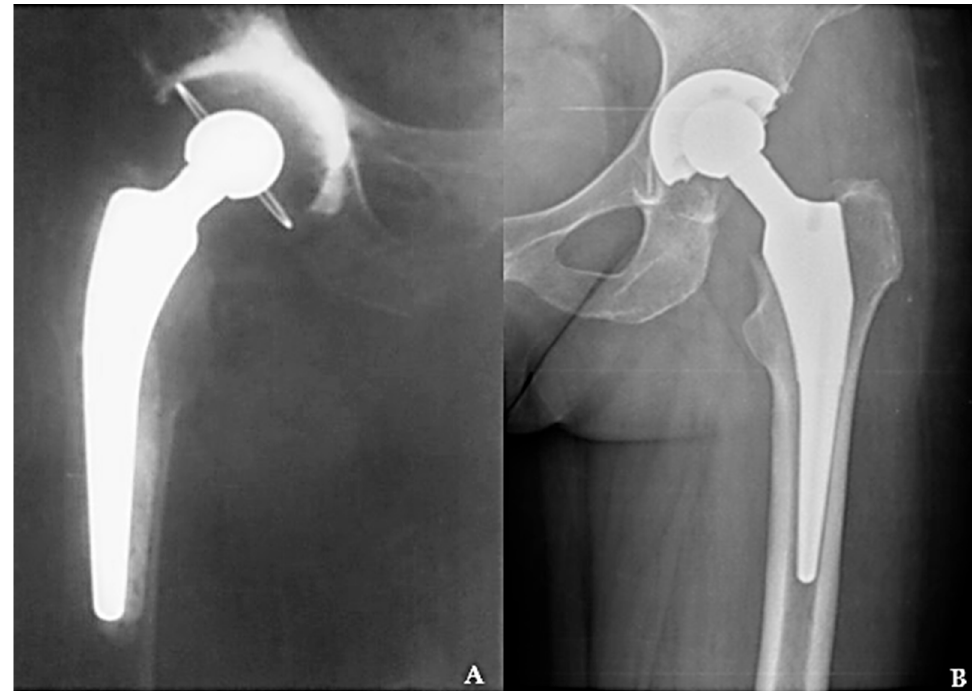
Figure 2. Total hip arthroplasty with CHP ( A ), versus a CLHP ( B ).